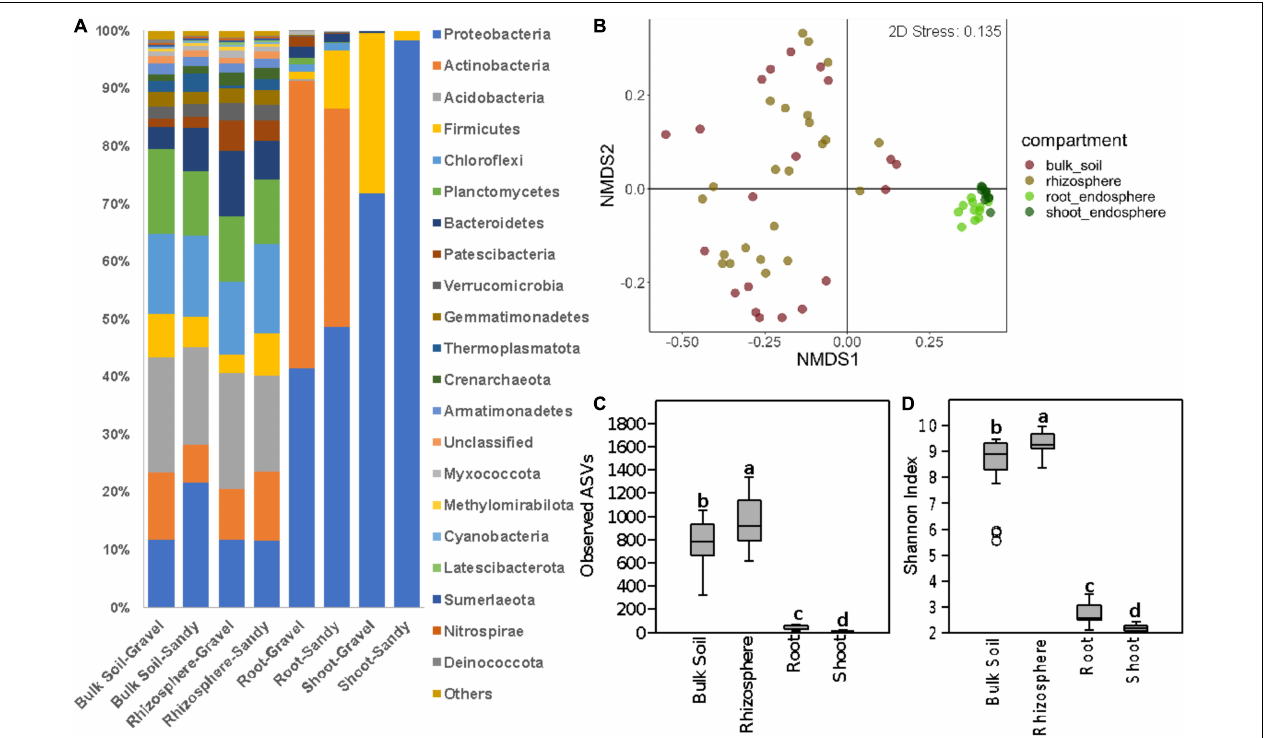
FIGURE 2 | Bacterial community composition and diversity in all sampling compartments. (A) Bar charts show the relative abundance of the dominant phyla in bulk soil, rhizosphere, root endosphere, and shoot endosphere samples of plants growing in gravel or sandy soils. “Others” stand for the sum of other phyla with < 1.5% of relative abundance. (B) Bacterial community structure represented by a non-metric multidimensional scaling (NMDS) ordination based on the Bray-Curtis distance matrix of the 16S rRNA gene ASV table. Samples are colored according to the sampling compartment. (C,D) Differences in bacterial alpha-diversity between the four plant and soil compartments. (C) Bacterial species richness based on the number of observed ASVs. (D) Bacterial species diversity based on the Shannon index. Different letters indicate significant differences according to the Kruskal-Walli’s test ( p < 0.05).